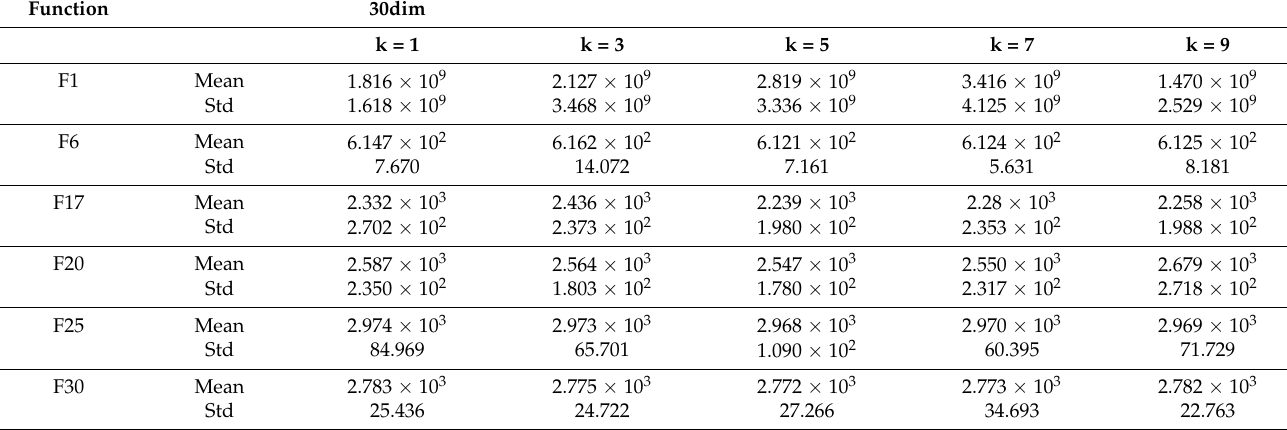
Table 2. The 30-dimensional function